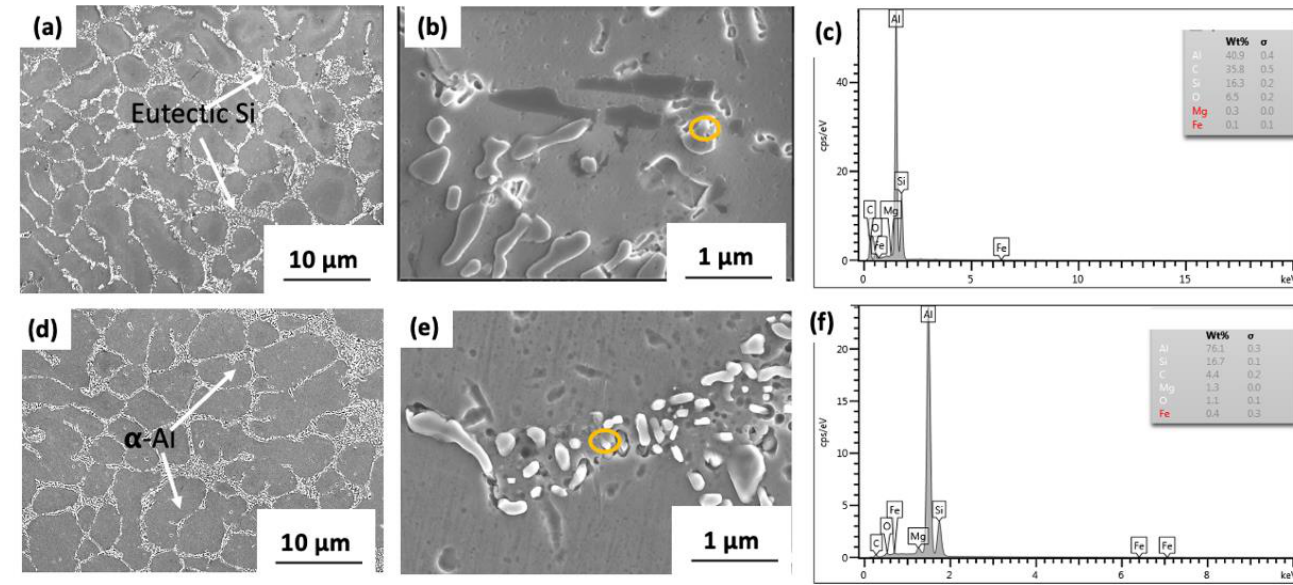
Figure 6. Backscattered images of thixoformed A356 alloy with the addition of ( a ) 0.3 wt.% GNPs and ( b ) high magnification images of 0.3 wt.%, ( c ) EDS spectrum for selected area (yellow circle), ( d ) 1.0 wt.% GNPs, ( e ) high magnification images of 1.0 wt.%, ( f ) EDS spectrum for selected area (yellow circle).